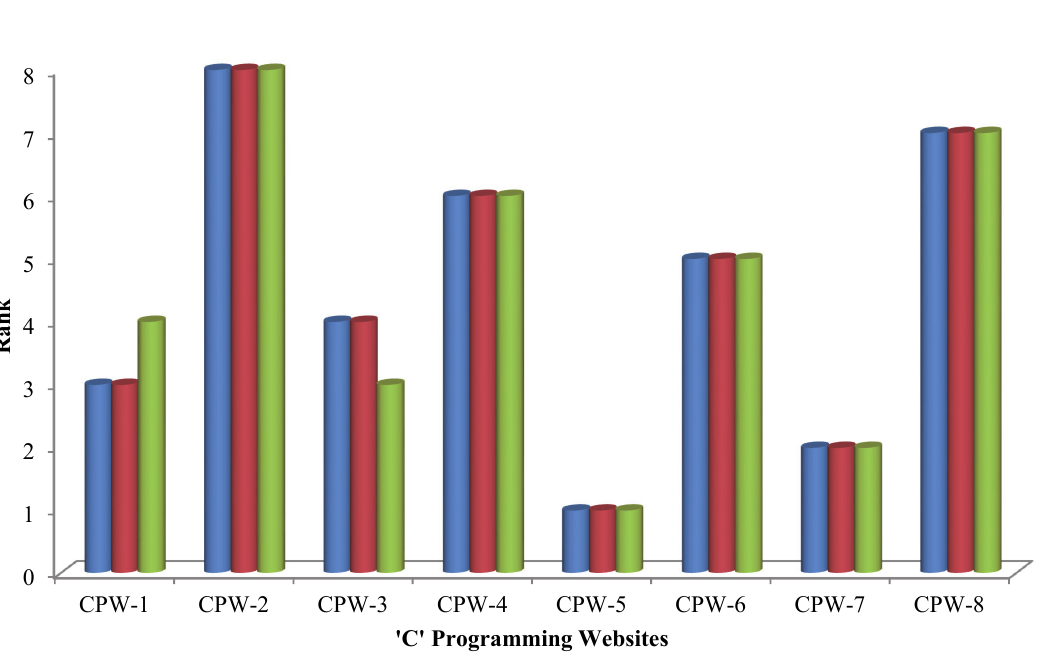
Fig. 4. Comparative rankings obtained using COPRAS, VIKOR and